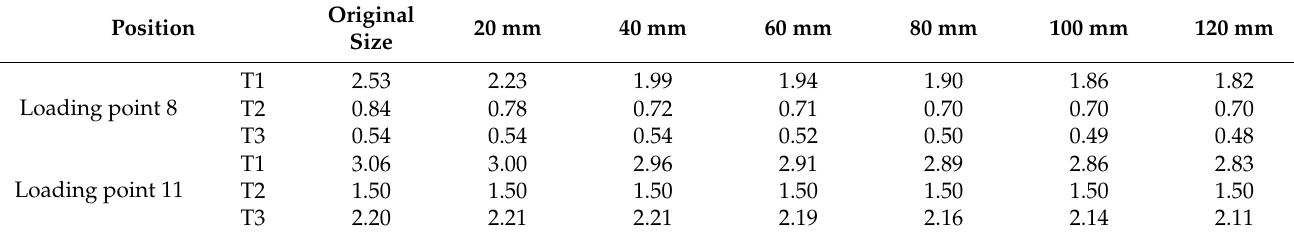
Table 13. Widen TLVT in the lateral direction (MPa).